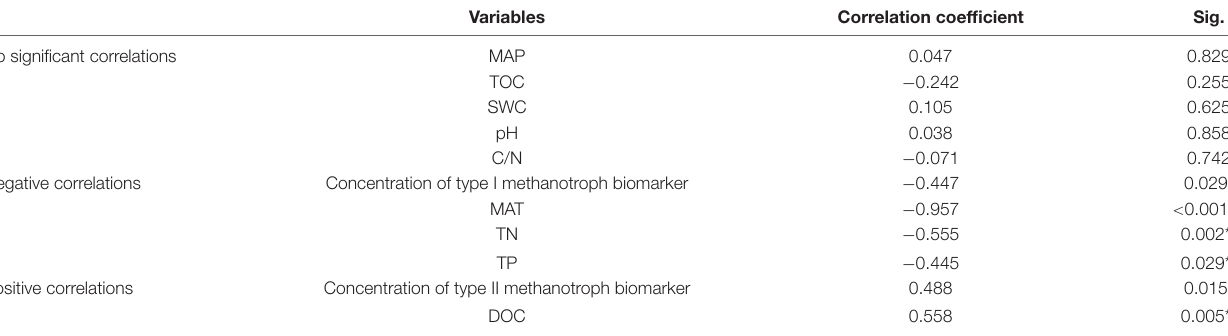
TABLE 3 | Pearson correlation coefficients between the concentrations of type I and type II methanotroph biomarker, environmental variables and the altitude.